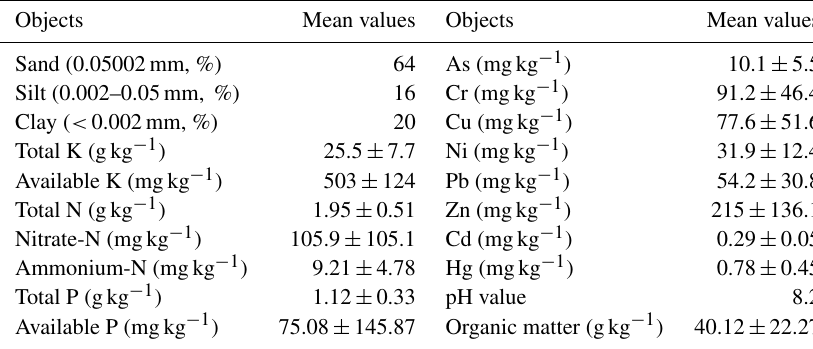
Table 1. Basic physical and chemical properties of LSW ( ± standard deviation). Objects Mean values